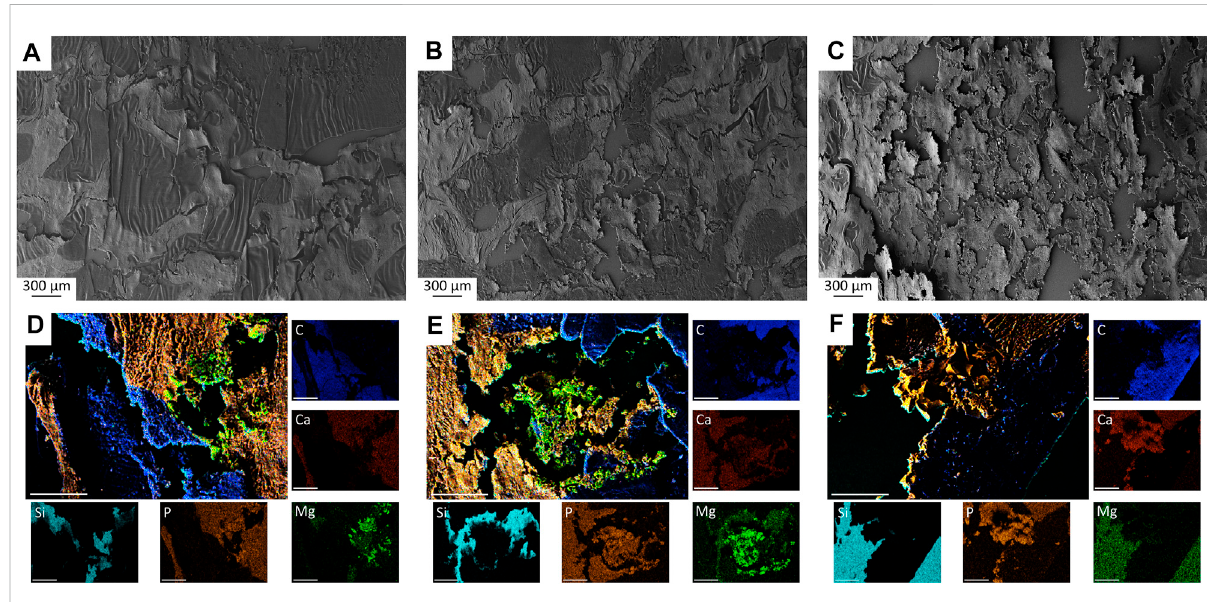
FIGURE 10 (A – C) SEM analysis of histological thin sections (×28 magni fi cation) with (A) Mg225d, (B) Mg225p and (C) TCP scaffold incorporated by newly formed cancellous bone after 12 weeks. (D – F) EDX analysis of histological thin sections (×500 magni fi cation) with (D) Mg225d, (E) Mg225p and (F) TCP particles incorporated by newly formed cancellous bone after 12 weeks. Scale bar = 50